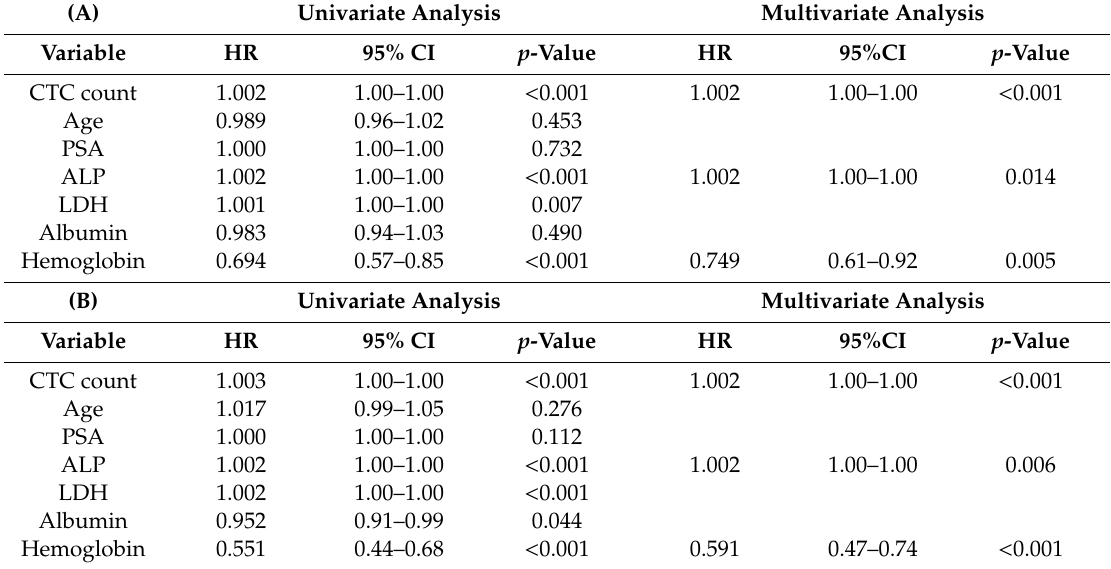
Table 3. Cox Regression analysis ( n =